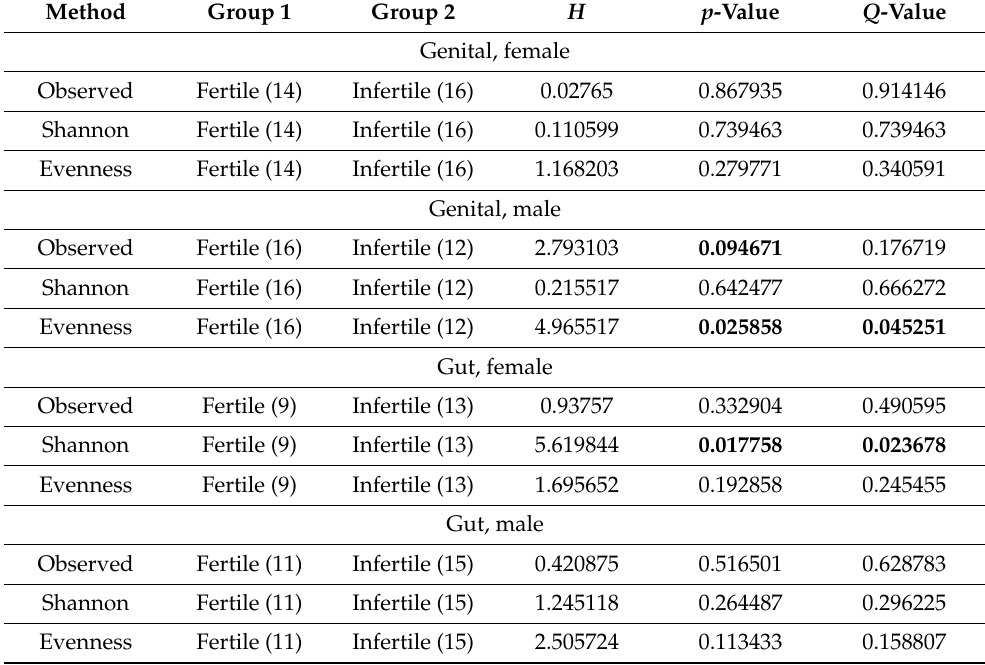
Table 6. Differences in the alpha-diversity of KO metagenome between samples. (<0.1 are in